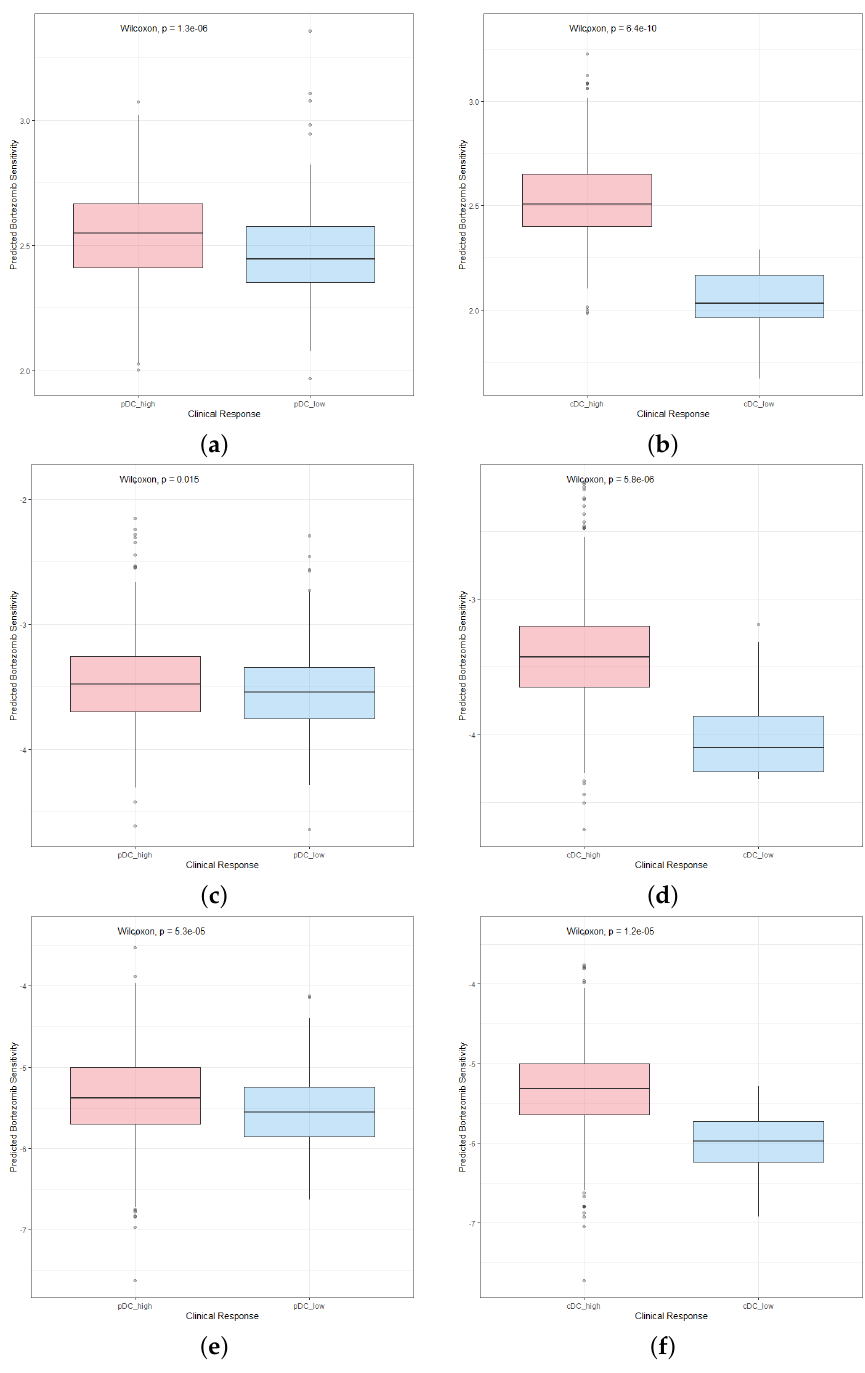
Figure 9. Visualization of the differences in the sensitivities of breast cancer patients with different DC abundances to chemotherapeutics. ( a , b ) Breast cancer patients with a high abundance of pDCs and cDCs were more sensitive to lapatinib. ( c , d ) Breast cancer patients with a high abundance of pDCs and cDCs were more sensitive to paclitaxel. ( e , f ) Breast cancer patients with a high abundance of pDCs and cDCs were more sensitive to